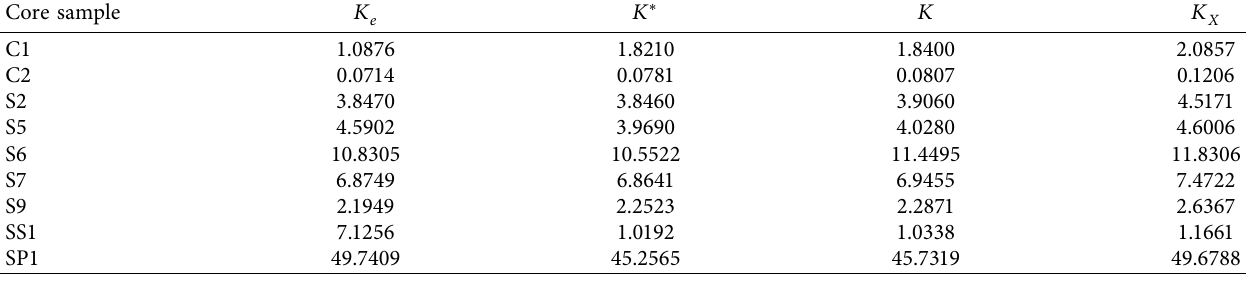
Table 3: Comparison of the predicted permeability values ( μ m 2 ) of the digital core samples.